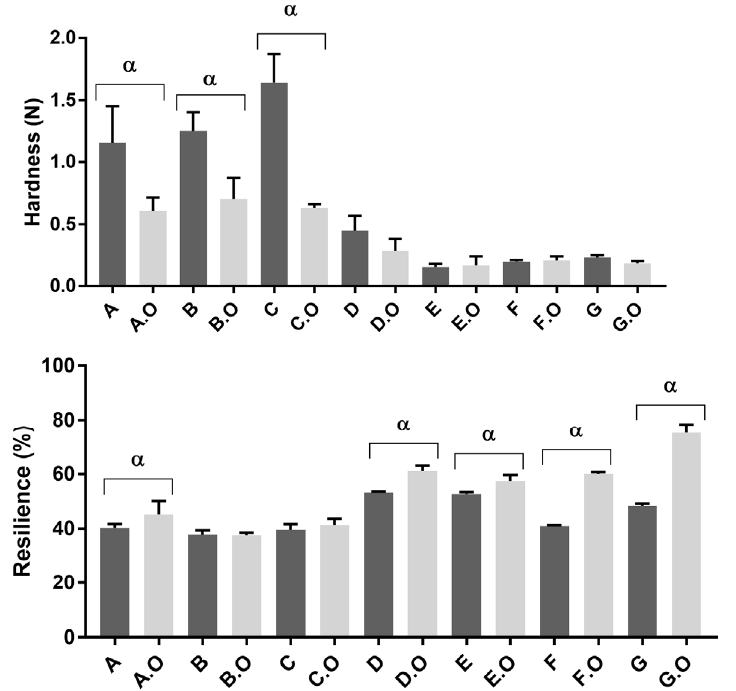
Figure 2. Study of textural properties of vaginal sheets: hardness (N)—part 1 and resilience (%)—part 2. α represents statistically significant difference between base formulation and formulation with oil ( p < 0.05).